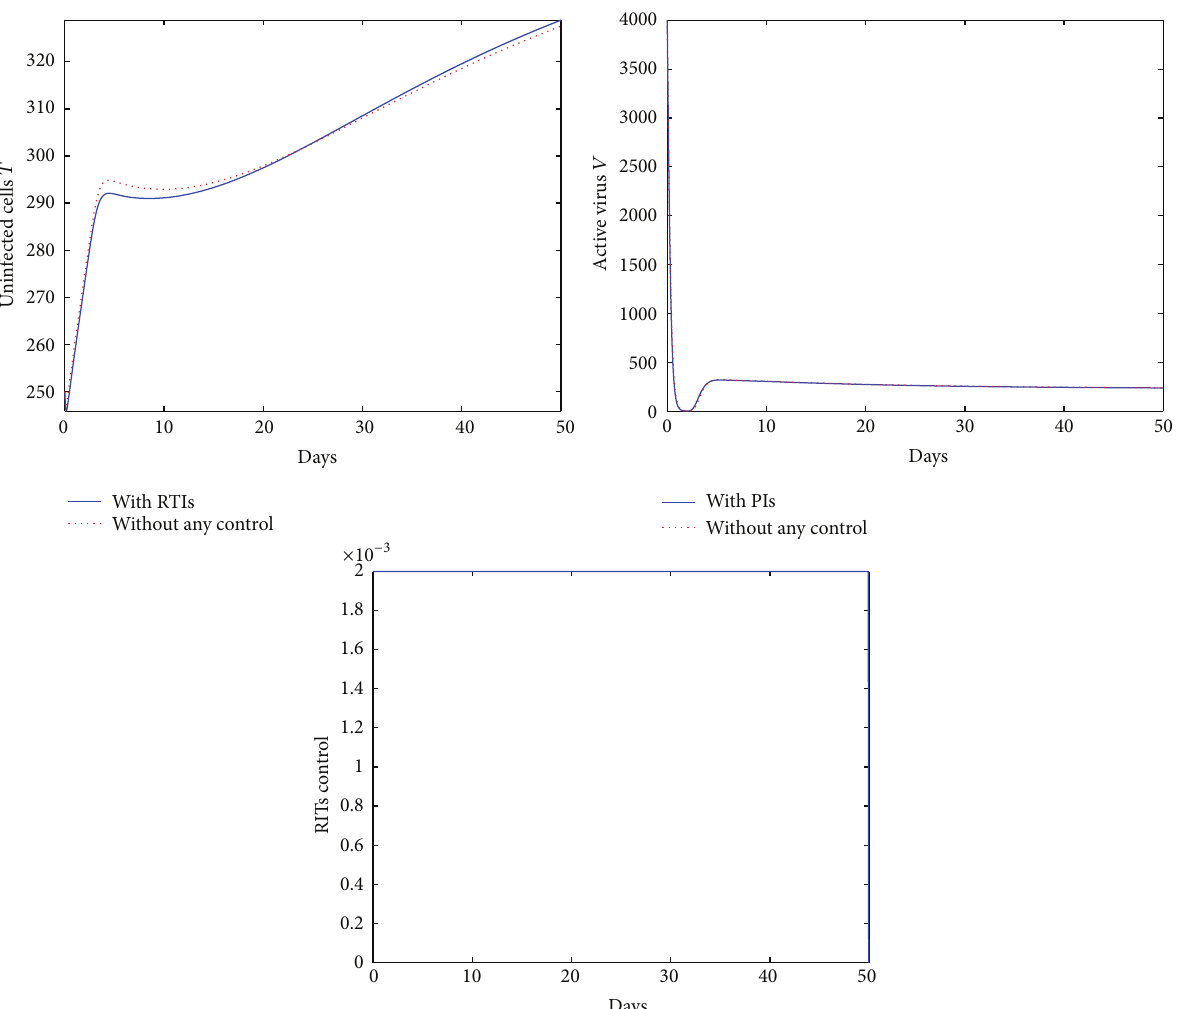
Figure 4: Optimal solutions only using RTIs with sufficiently small weight coefficient 𝛼 1 for a 50-day treatment.